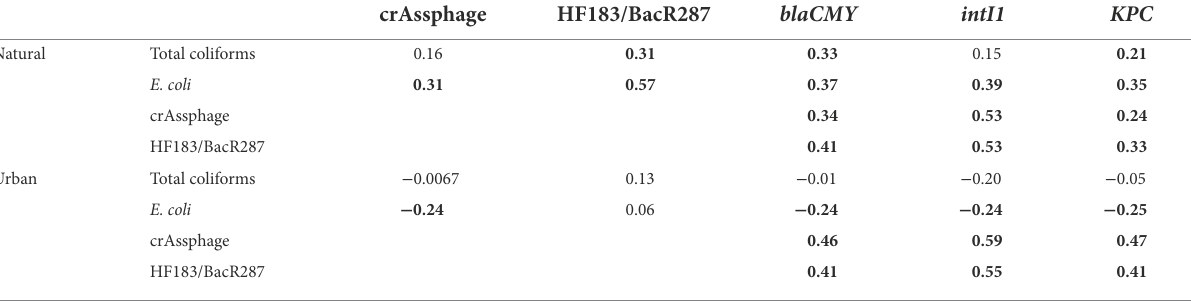
TABLE 3 Summary of correlations between fecal indicator bacteria (FIB; total coliforms and E. coli ), microbial source tracking (MST) markers (crAssphage and HF183/BacR287), and antibiotic resistance-associated genes (ARGs; blaCMY , intI1 , and KPC ) between the natural (Cochran Shoals) and urban (Paces Ferry)